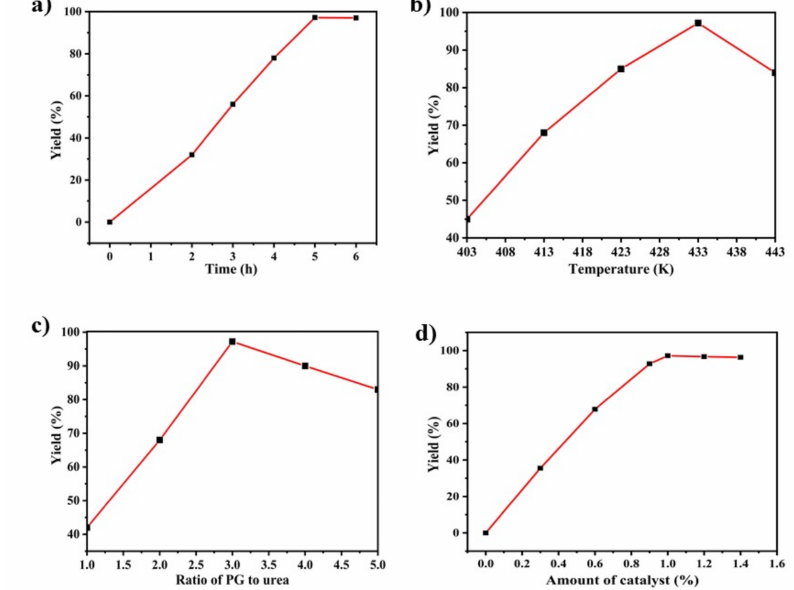
Figure 6. Process optimization research of the PC synthesis with e ff ect of duration time ( a ), temperature ( b ), mole ratio of PG to urea (n (PG) :n (urea) ) ( c ), and the amount of SMgAlO-5 catalyst in the reaction ( d ). Reaction conditions: SMgAlO-5 amount (1% for ( a – c )), reaction time (5 h for ( a – c )), n (PG :n (urea) (3:1 for ( a , b , d )), and temperature (433 K for ( b – d